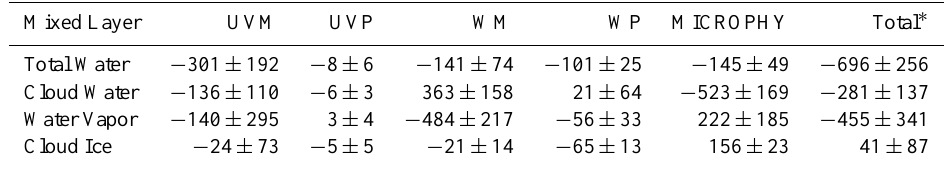
Table 4. The same as Table 3 except for the mixed layer